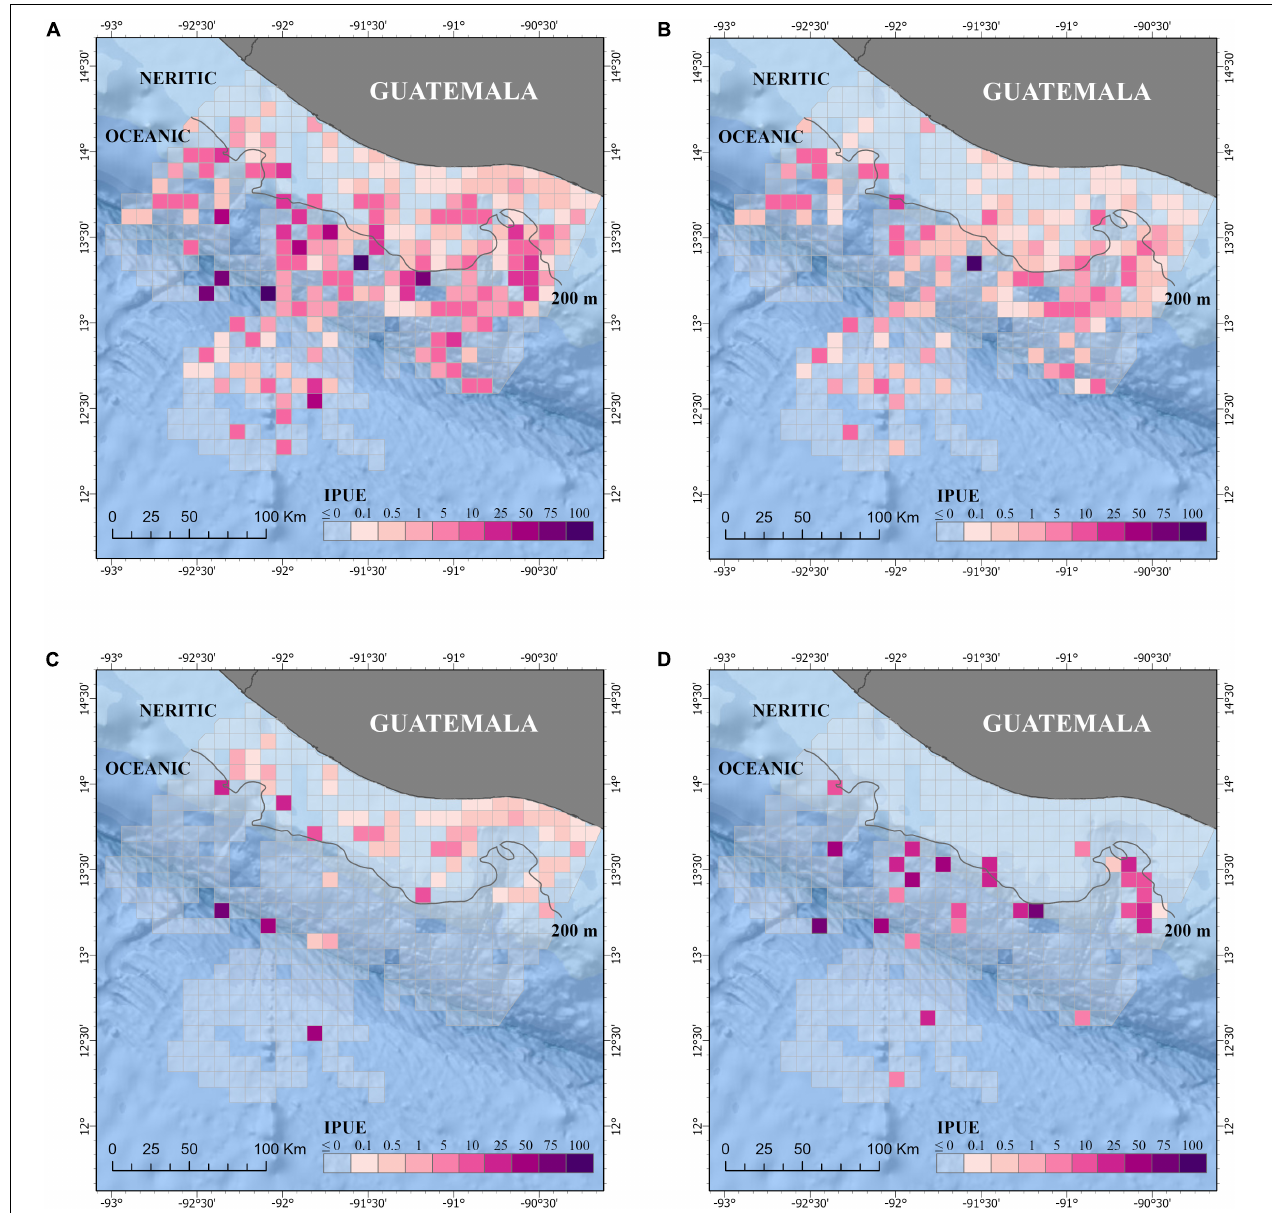
FIGURE 3 | Relative abundance is defined as individuals per survey effort (IPUE) of all small cetacean species (A) and the three most common species: (B) Tursiops truncatus , (C) Stenella attenuata , and (D) Stenella longirostris in the Pacific waters of Guatemala. Effort is km of survey summarized by 10 km × 10 km grid cells. Neritic ( < 200 m depth) and ocean ( > 200 m depth) zones are also included. Additional details of the study area are shown in Figure 1